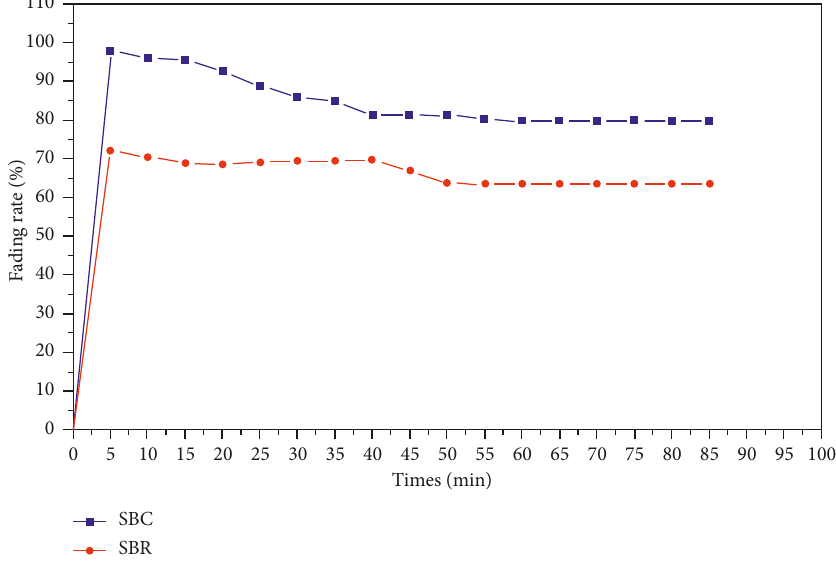
Figure 5: The evolution of the effluent discoloration as a function of time for both types of RS and CS wood.